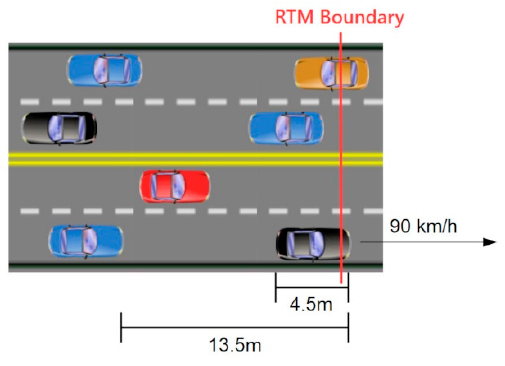
Figure 5. Traffic diagram.